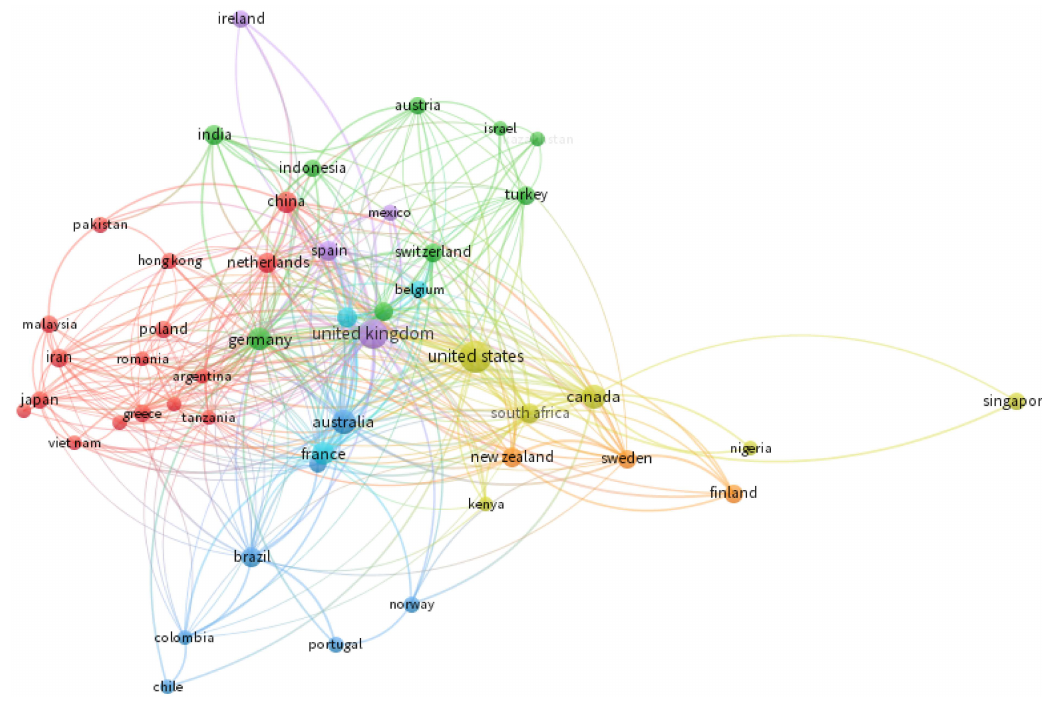
Figure 3. Co-authorship analysis at the country level.